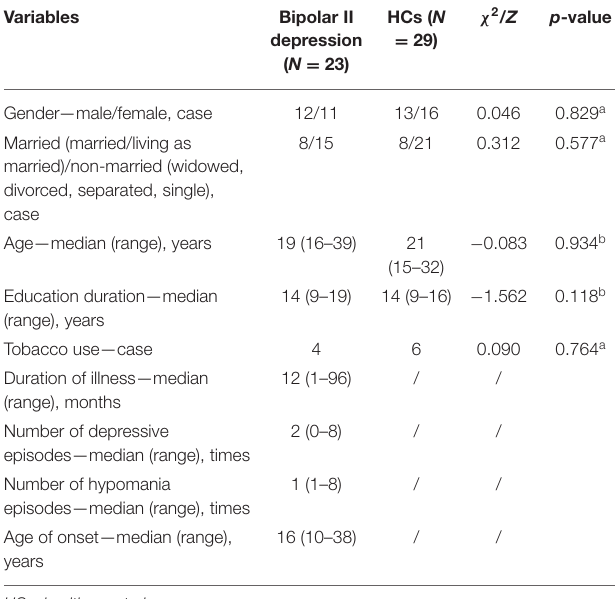
TABLE 1 | Demographic and clinical characteristics of medication-free patients with bipolar II depression and HCs.